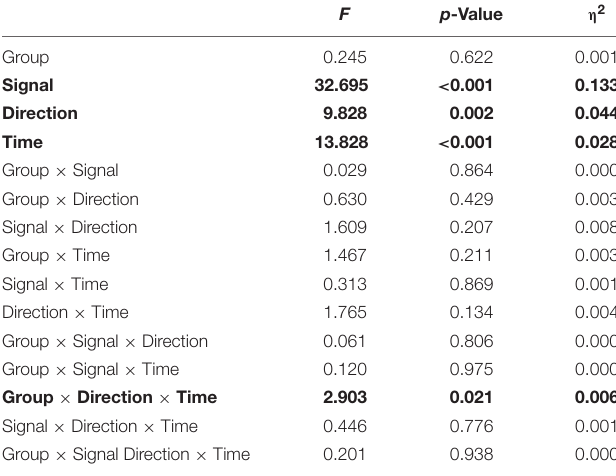
TABLE 2 | Results of four-way mixed